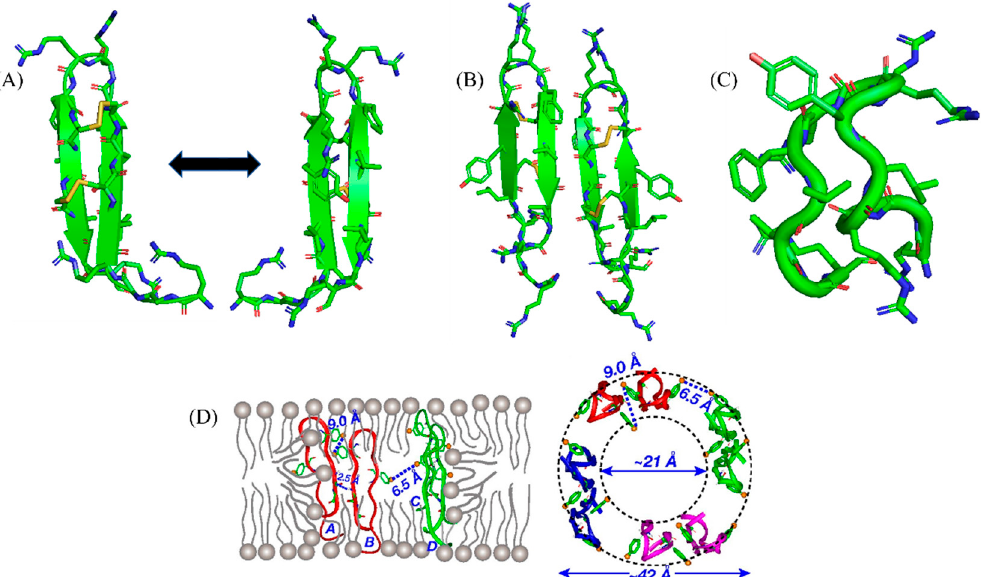
Figure 3. ( A ) In a solution containing zwitterionic detergent micelle, free PG-1 folds into a typical monomeric beta-hairpin structure [77]. ( B ) The solid-state NMR analysis demonstrated that PG-1 may create a pore-like shape in a model membrane rich in negatively charged lipids [78]. ( C ) LPS- bound solution NMR structure of Cys-deleted PG-1 (CDP) [81]. ( D ) The water-filled pore structure is maintained by the reorganization of oligomeric PG-1 and lipid chains. PG-1-like pore shape was not seen in cholesterol-rich zwitterionic lipid bilayers that mimic eukaryotic membrane compositions [76]. ( D ) is reproduced from reference 76 Mani, R.; Cady, S.D.; Tang, M.; Waring, A.J.; Lehrer, R.I.; Hong, M. Membrane-dependent oligomeric structure and pore formation of a beta-hairpin antimicrobial peptide in lipid bilayers from solid-state NMR. Proc Natl Acad Sci USA 2006 , 103 , 16242–16247, doi:10.1073/pnas.0605079103, “Copyright (2006) National Academy of Sciences, USA.”